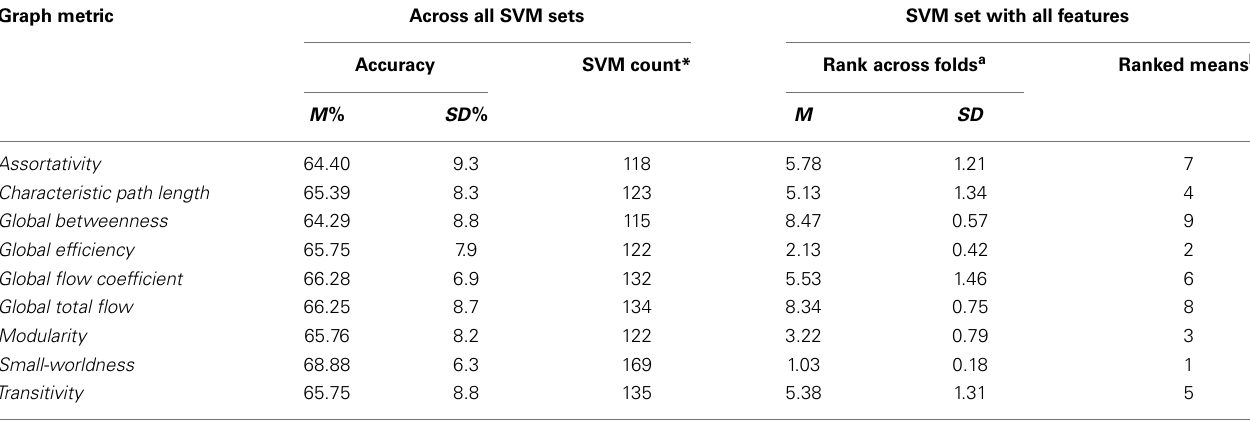
Table 5 |Accuracy of SVMs sorted by individual graph metric and feature weight ranks for SVM set with all features . Graph